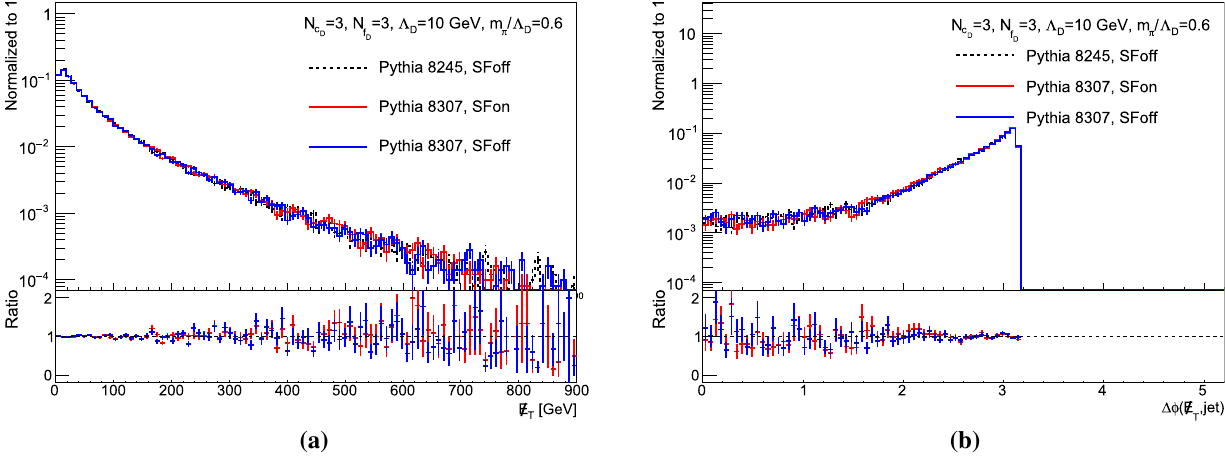
= 3, N = 3 model: a Distribution of the generator level missing transverse energy (cid:3) E Fig. 31 N c f D D angle between jets and (cid:3) E T . The bottom panels show the ratio of the distributions of the new HV module scenarios to the nominal one